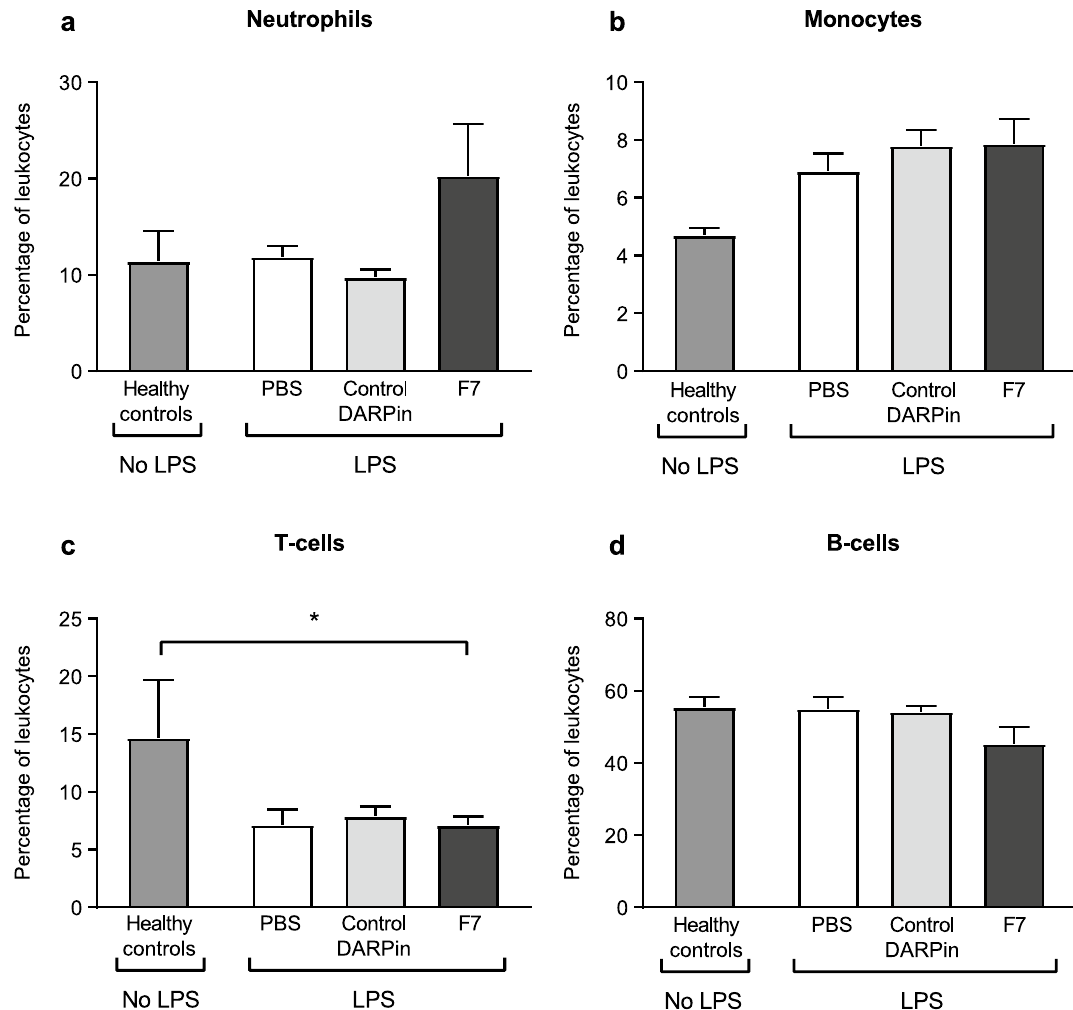
Figure 6. Percentages of blood leukocytes are similar between the different treatment groups in the chronic phase. Blood was harvested on day 10 and analyzed using flow cytometry as described in the “Methods” section. ( a,b ) Percentages of neutrophils and monocytes were similar between the different treatment groups. ( c ) Percentages of T-cells were significantly higher in the healthy control group compared to the F7 treated group. There was no significant difference between the other treatment groups. ( d ) No significant differences were observed regarding the percentage of B-cells between the different treatment groups and compared to healthy controls. Data are presented as mean ± SEM. n = 5–10, * p < 0.01. Treatment groups were compared by an unpaired